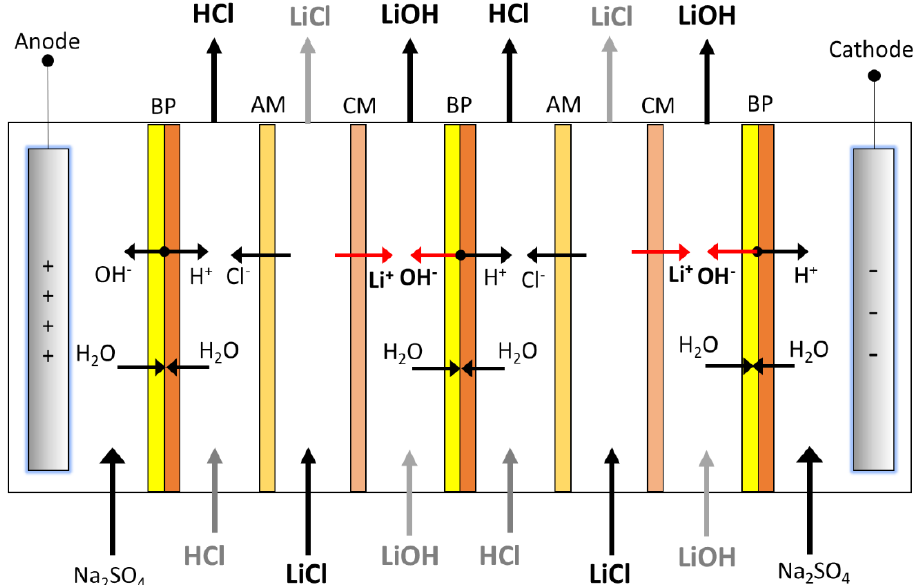
Figure 3. LiOH production by bipolar membrane electrodialysis; configuration of two three-compartment cells. BP: Bipolar membrane, AM: Anion exchange membrane, CM: Cation exchange membrane.